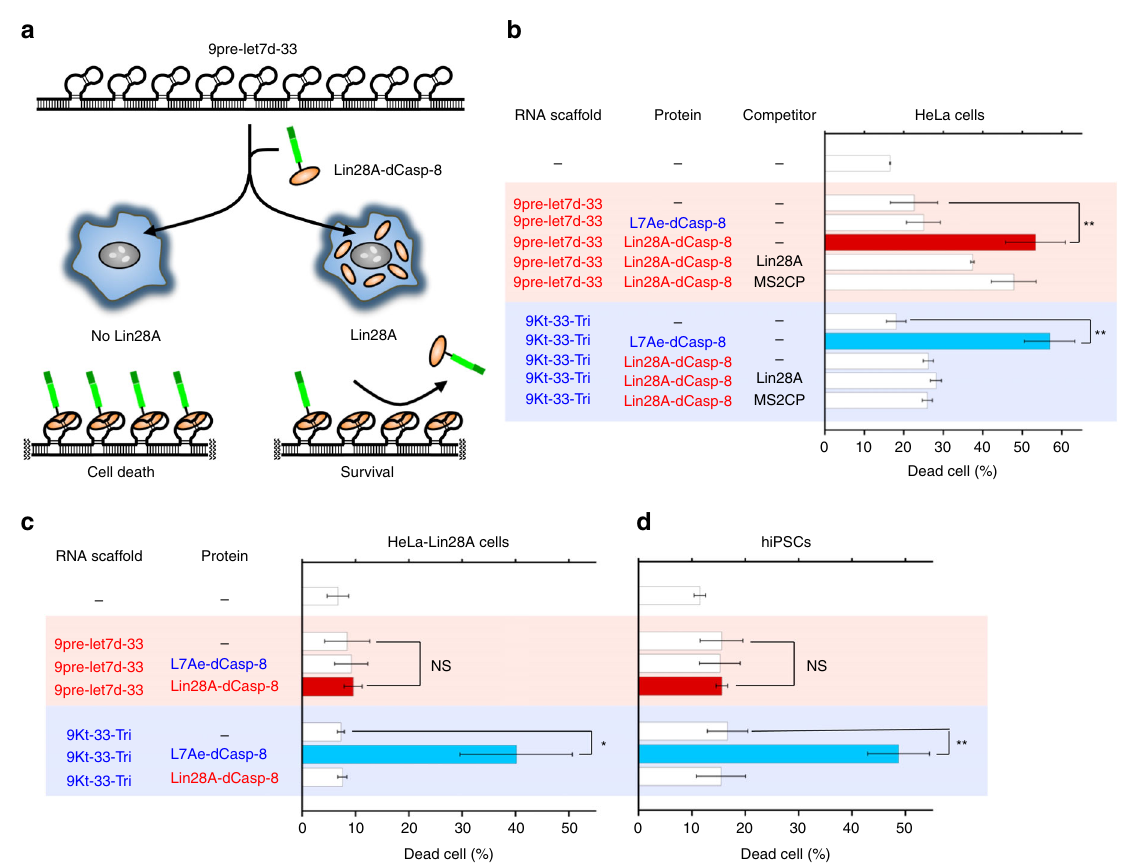
Fig. 5 RNA scaffold-mediated cell-death control by Lin28A detection. a Schematic representation of a Lin28A-responsive RNA nanostructured device composed of 9pre-let7d-33 and Lin28A-dCasp-8. b Lin28A-responsive control of cell fate using 9pre-let7d-33 and Lin28A-dCasp-8 in HeLa cells. L7Ae-responsive 9Kt-33-Tri was used as a control. Cell death is induced in the presence of both 9pre-let7d-33 and Lin28A-dCasp-8. The induction of cell death is partially repressed by adding Lin28A-coding modRNA as a competitor. c , d Selective cell-fate control by detecting Lin28A in HeLa-Lin28A cells ( c ) and hiPSCs ( d ). Dead cells were stained with Paci fi c Blue Annexin V and analysed using fl ow cytometry. The data are presented as the mean ± SD ( n = 3). NS not signi fi cant, * P < 0.05, ** P < 0.01 (Welch ’ s t